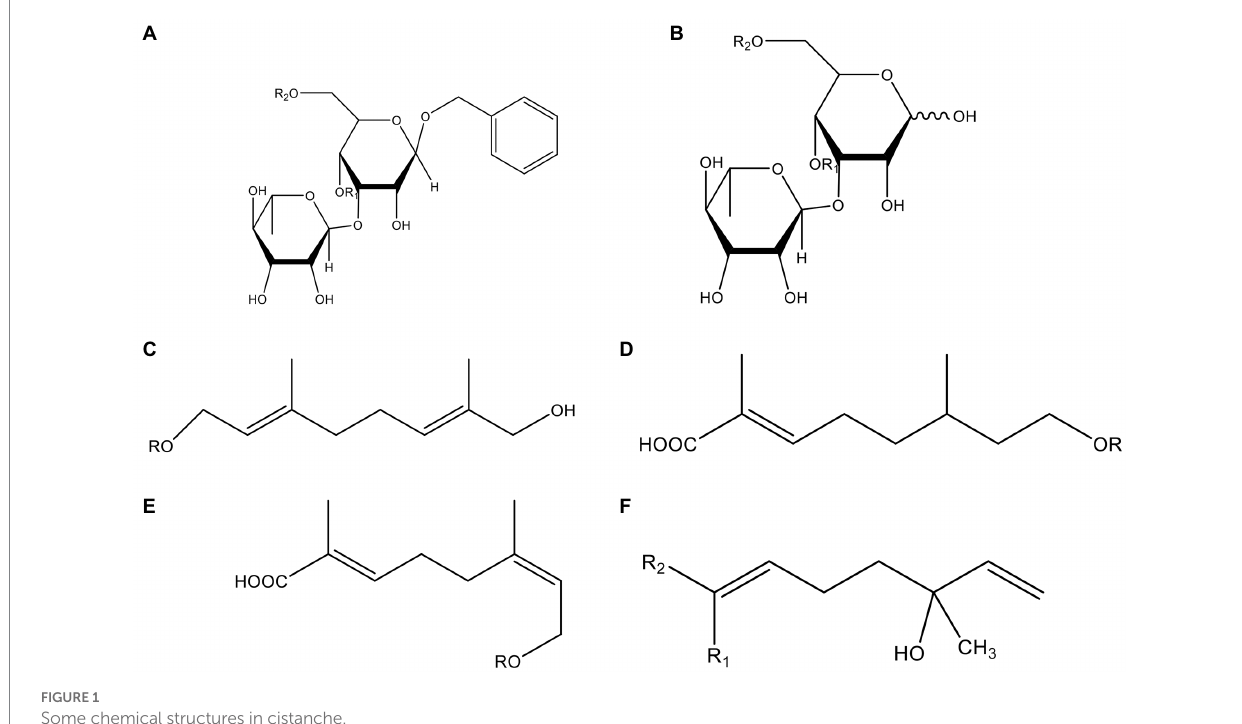
FIGURE 1 Some chemical structures in cistanche.